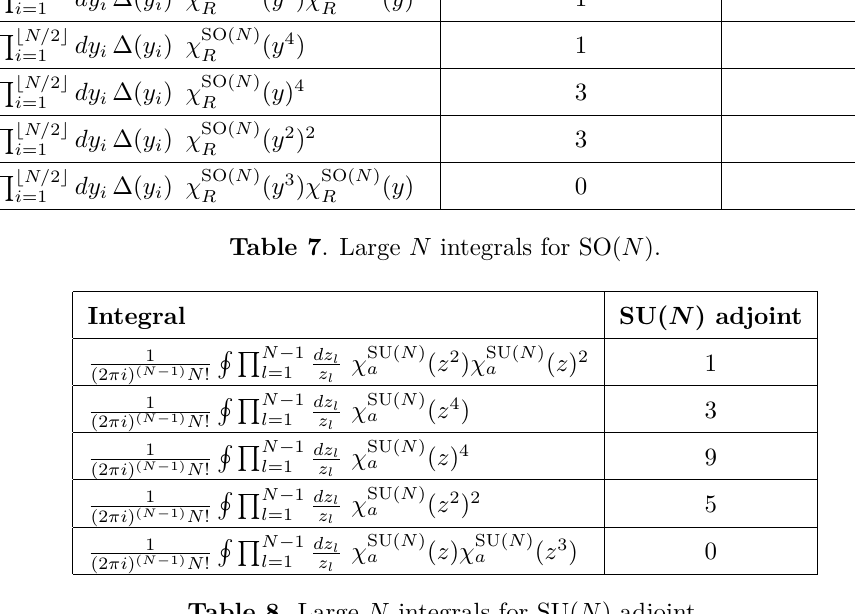
Table 8 . Large N integrals for SU( N )